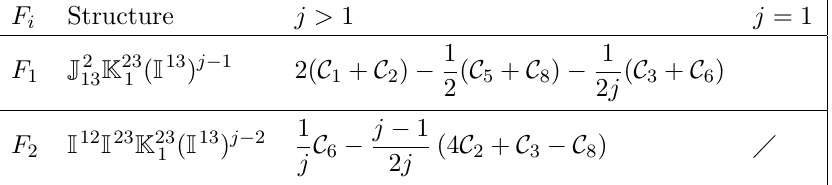
( QO ) SO when QO has h i = C 6